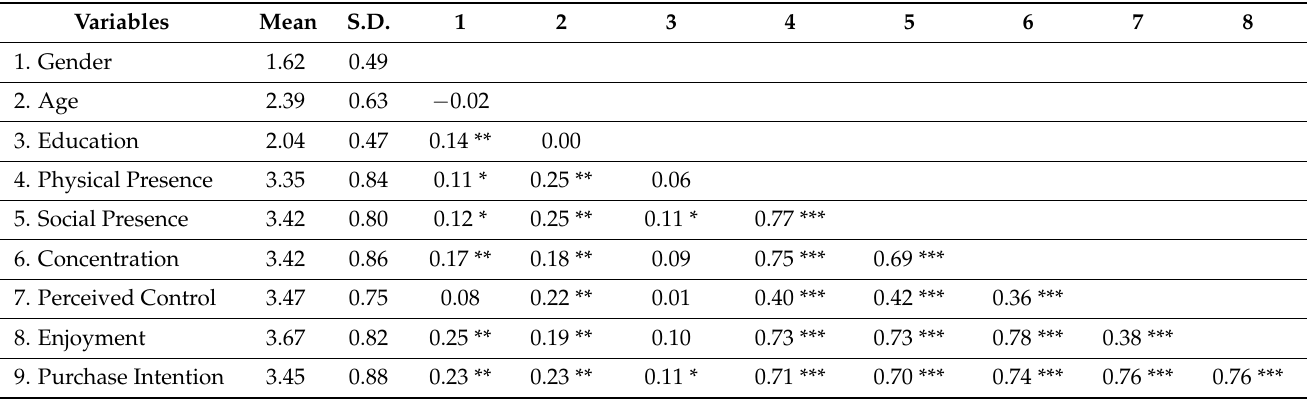
Table 3. Mean, S.D., and